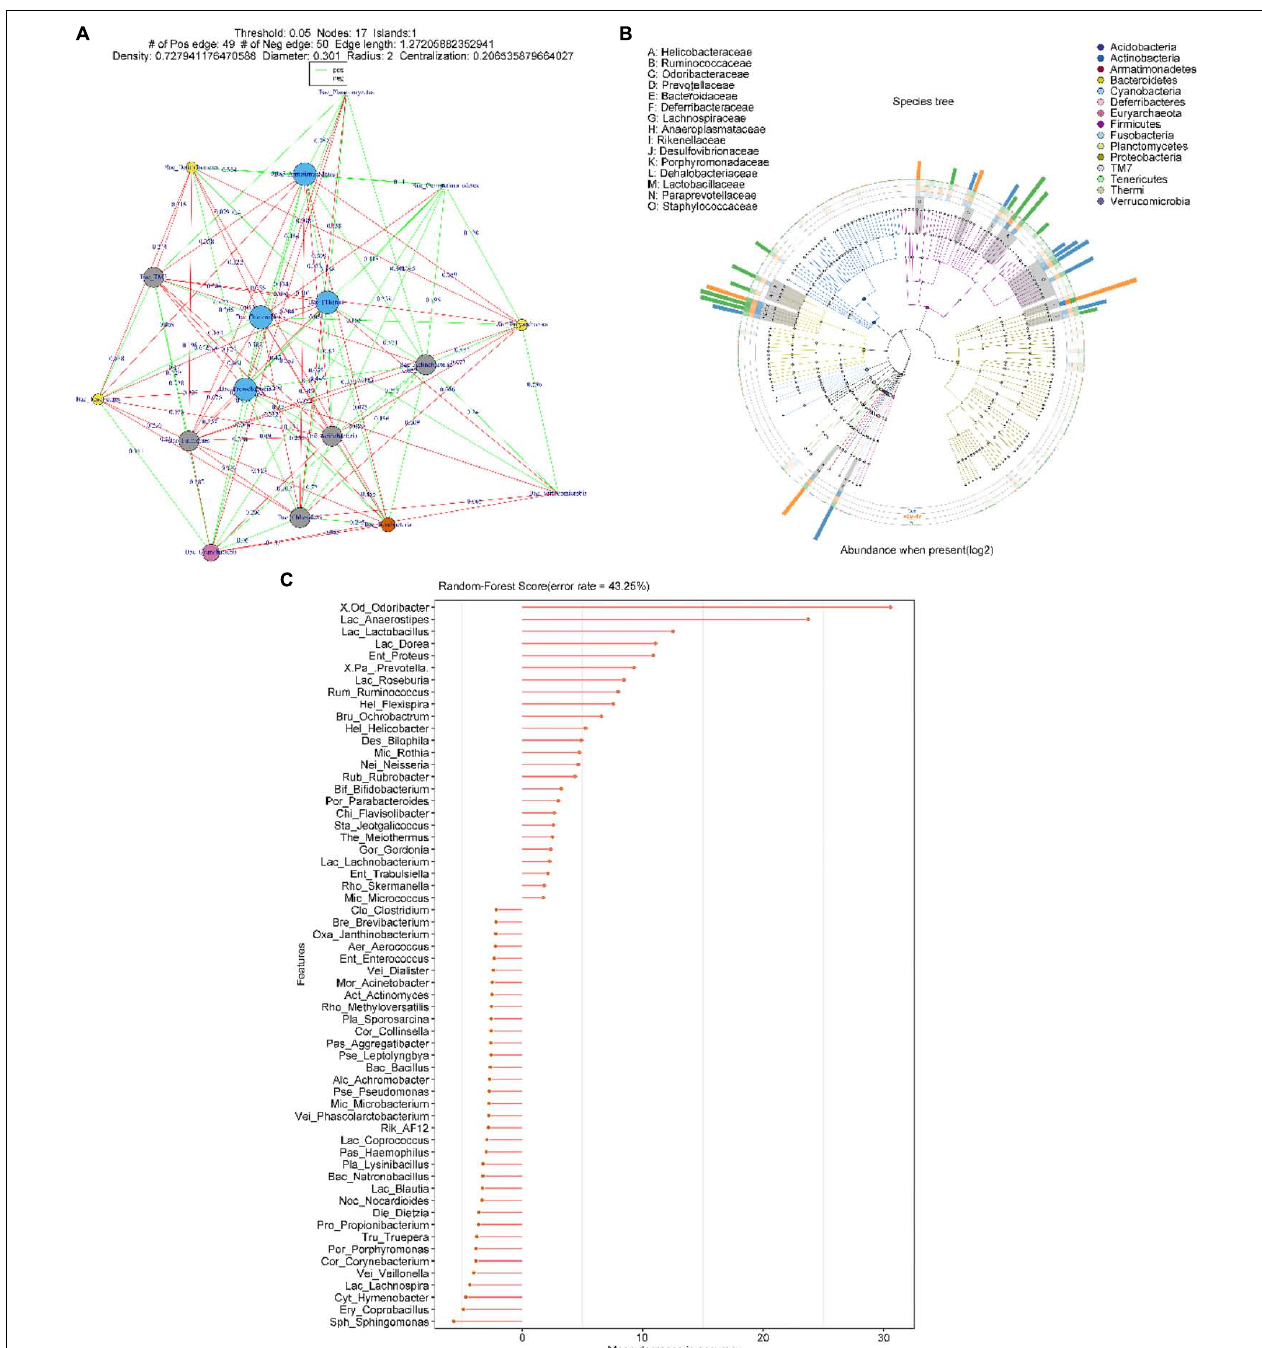
FIGURE 5 | Sequencing analysis of the fecal samples from mice given Fn gavage. (A) The relationship between microorganisms at the phylum level; (B) distribution map of sample community of species evolutionary tree; and (C) species importance point map.